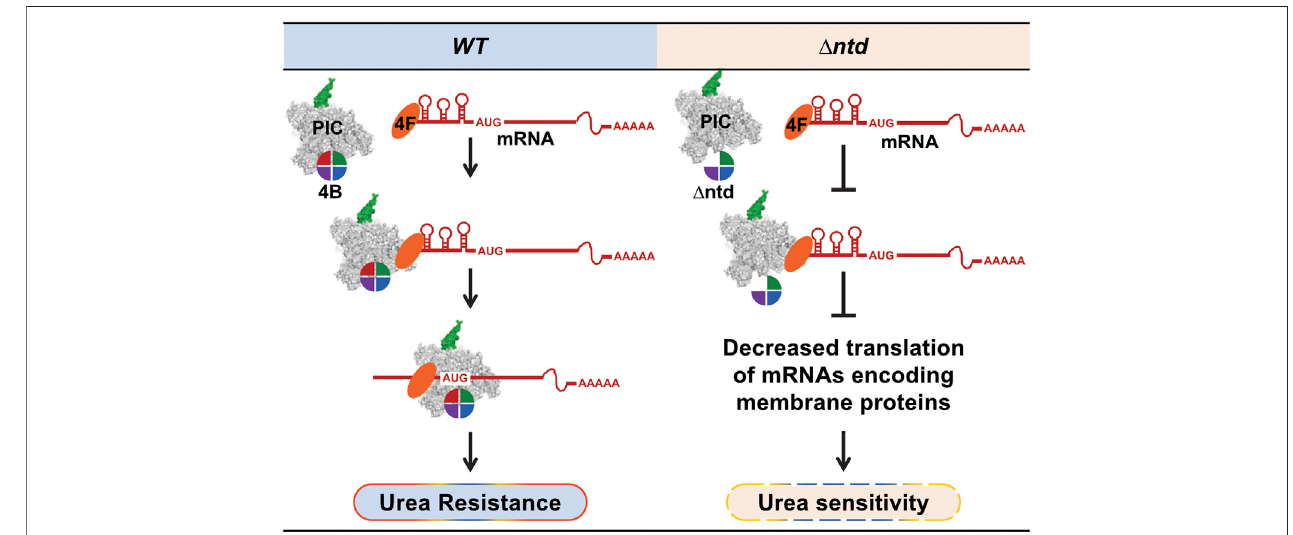
FIGURE 6 | The NTD of eIF4B enhances translation ef fi ciency of mRNAs with structured 5 ′ -UTRs and allows a robust cellular response to urea. WT eIF4B promotes PIC loading and scanning of all mRNAs. Deletion of the NTD of eIF4B reduces translation ef fi ciency of mRNAs with long structured 5 ′ UTRs to a greater extent, indicating eIF4B promotes ribosome loading and scanning while bound to the PIC. Translation of these highly structured mRNAs may be required to recon fi gure the membrane proteome and balance translation of cytoplasmic proteins, providing urea